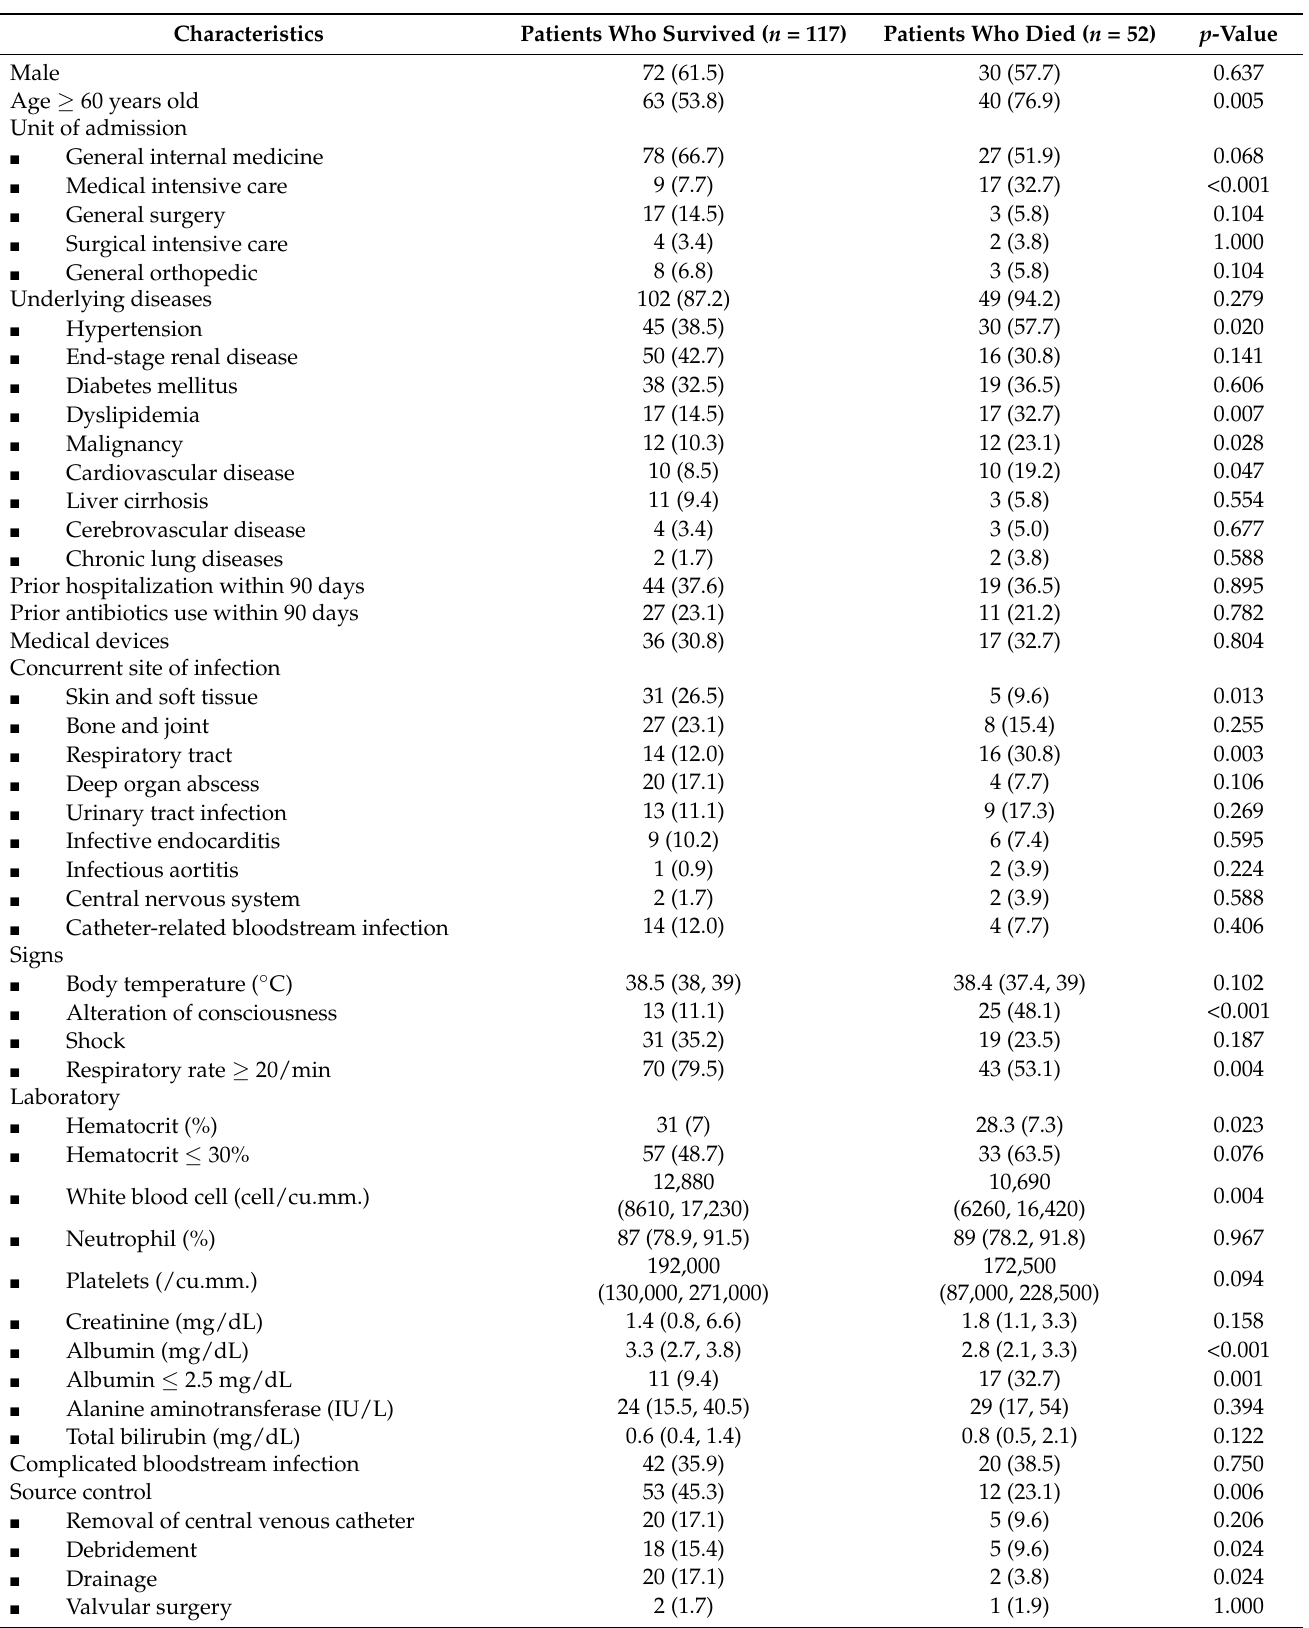
Table 4. Comparison of the characteristics of patients with Staphylococcus aureus bloodstream infec- tions who survived and who